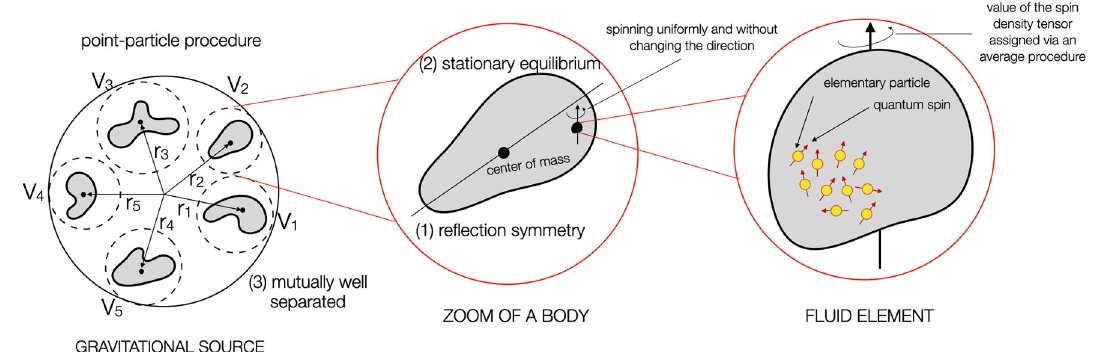
Fig. 1 A pictorial sketch explaining the point-particle limit and the hypothesesunderlyingourcalculations,wherethebodiesare:(1)reflec- tion symmetric about their center of mass; (2) in stationary equilibrium; (3) mutually well separated. In the Weyssenhoff fluid framework, the